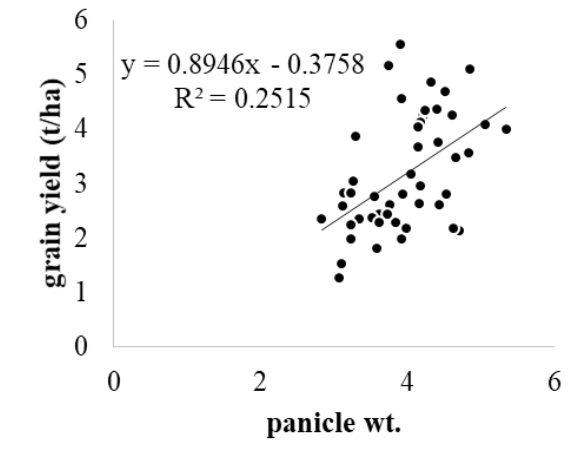
Figure 2: Scattered plot of grain Yield vs plant ht